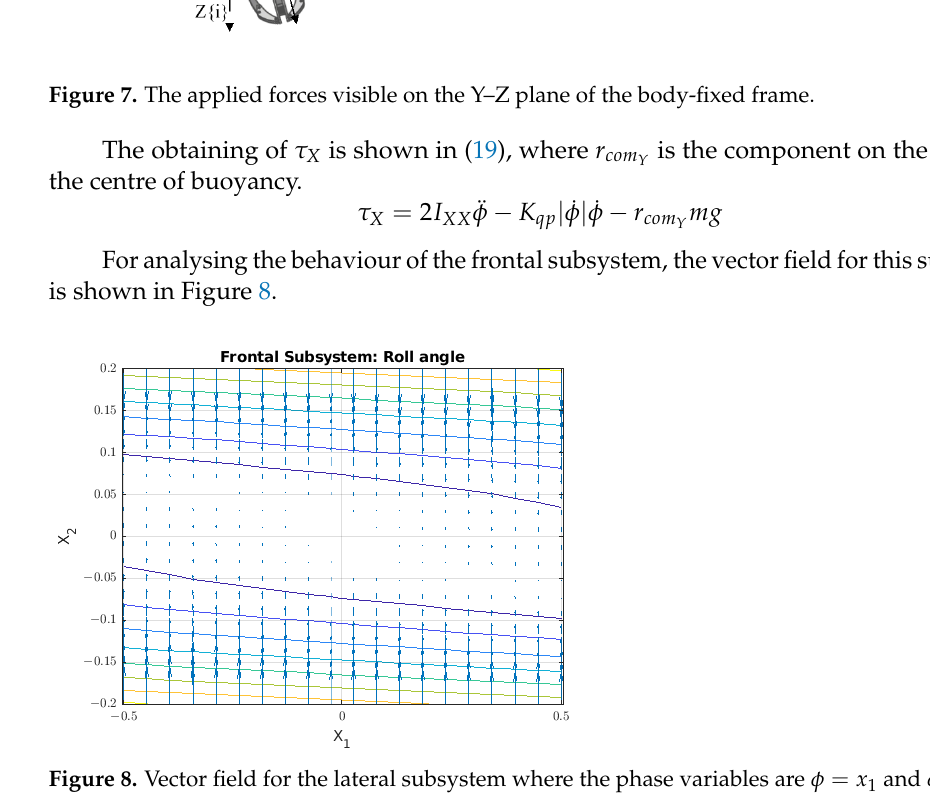
Figure 8. Vector field for the lateral subsystem where the phase variables are φ = x 1 and ˙ φ = x 2